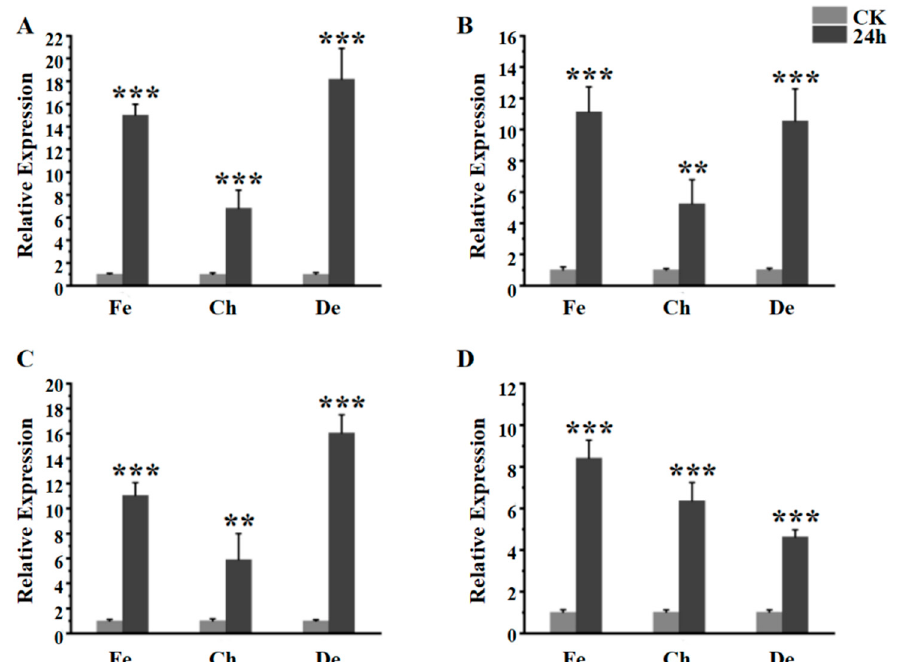
Figure 2. The gene expression of fourth instar larva after Chlorpyrifos, deltamethrin and fenpropathrin stimulated. ( A ) EoACP138 gene ( B ) EoCYP316 gene (C) EoCarE592 gene ( D ) EoAchE989 gene, where CK was the 0 h treatment control, Fe was fenpropathrin, Ch was chlorpyrifos, and De was deltamethrin. Each bar represents the mean ± SD. Asterisks indicate significant differences between 0 h and 24 h expression. ** = p < 0.01, and *** = p < 0.001.